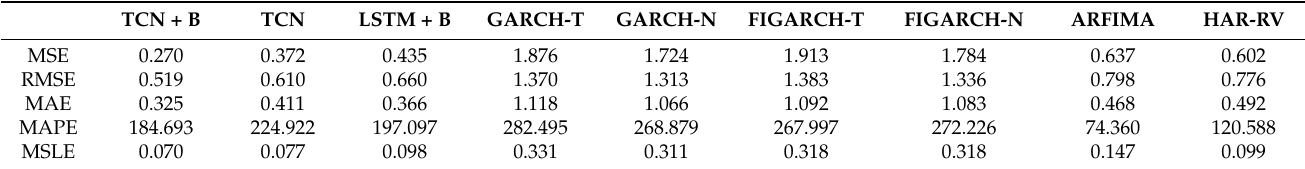
Table 9. Prediction error of each model (step size is 2). FIGARCH-T FIGARCH-N ARFIMA HAR-RV